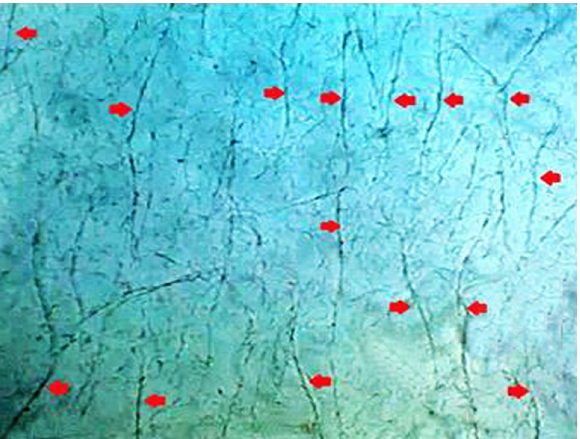
Figure 1. Sharkasi sperm agglutinations forming thread-like bundles in a static environment on a glass slide under phase contrast microscope. A magnification of (× 200) was used.